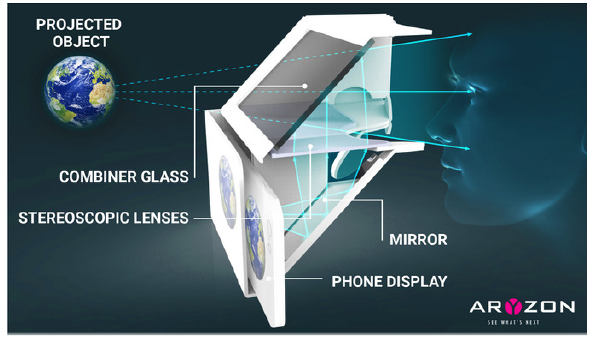
Figure 6. Aryzon 3d operating scheme.